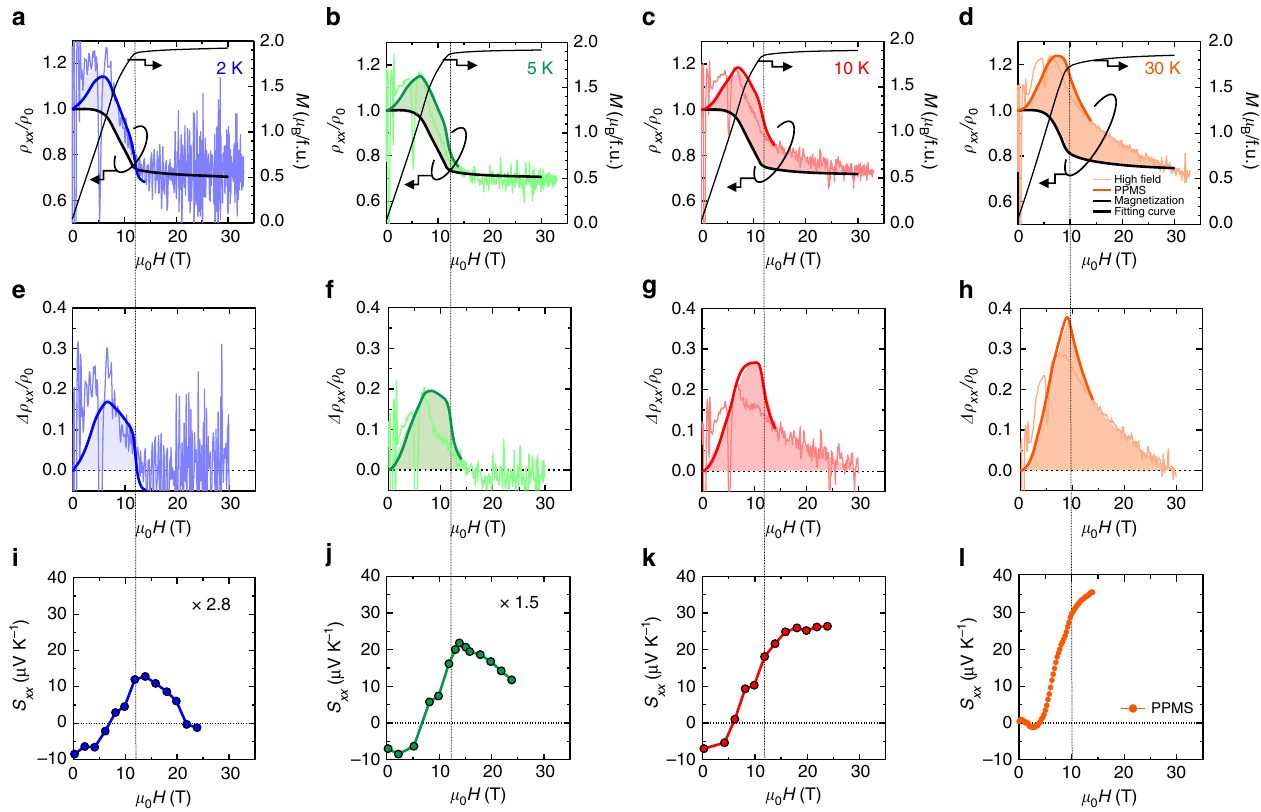
Fig. 4 Magneto-resistivity and thermopower in MnGe at high-magnetic fi elds. a – d Longitudinal magneto-resistivity (MR) measured by pulsed magnet at low temperatures ( T = 2, 5, 10, 30 K). Thick-line curves are the results on the same sample by steady- fi eld measurements (PPMS) up to 14 T. Bold black curves are the estimated conventional MR associated with the variations of magnetization shown in the black thin lines. Large noises, in particular for the low- fi eld and low-temperature region, in the pulse- fi eld results are due to the low resistivity of the sample, < 10 μΩ cm. e – h The estimated positive MR contributions due to the emergent- fi eld fl uctuations, which correspond to the color-shaded regions in a – d . i – l Magnetic- fi eld dependence of thermopower at low temperatures measured with a 25 T superconducting magnet ( T = 2, 5, 10 K) and PPMS ( T = 30